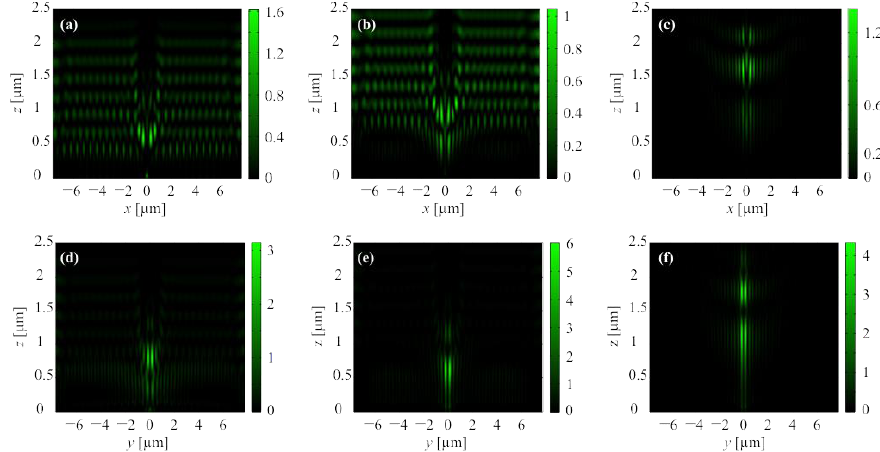
Figure 10. The instantaneous longitudinal of the intensity of the second-order CVB focused by chromium BZP pattern in XZ-plane ( a – c ) and YZ-plane ( d – f ) at the time moment of 100.07 fs ( a , d ), 114.08 fs ( b , e ), and 188.13 fs ( c , f ).